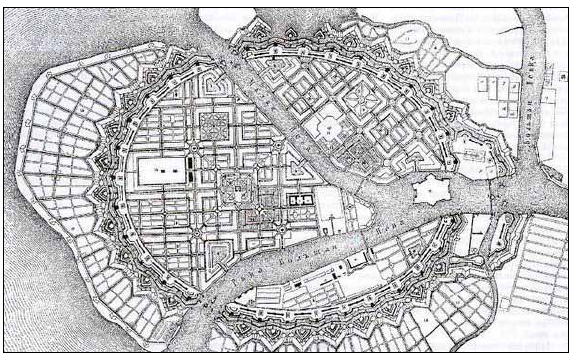
fig. 1. le Blond’s plan developed for Saint Petersburg